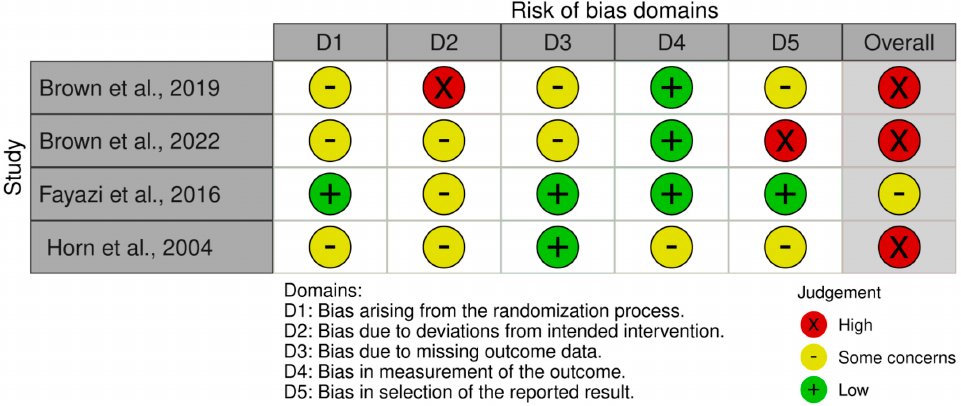
Figure 2. Risk of bias assessment of the included studies [21–24].